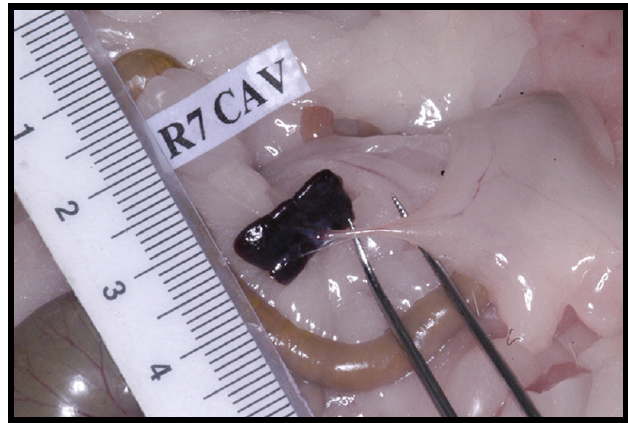
FIGURE 5 - The group I graft with presence of a vessel originating from revascularization of the